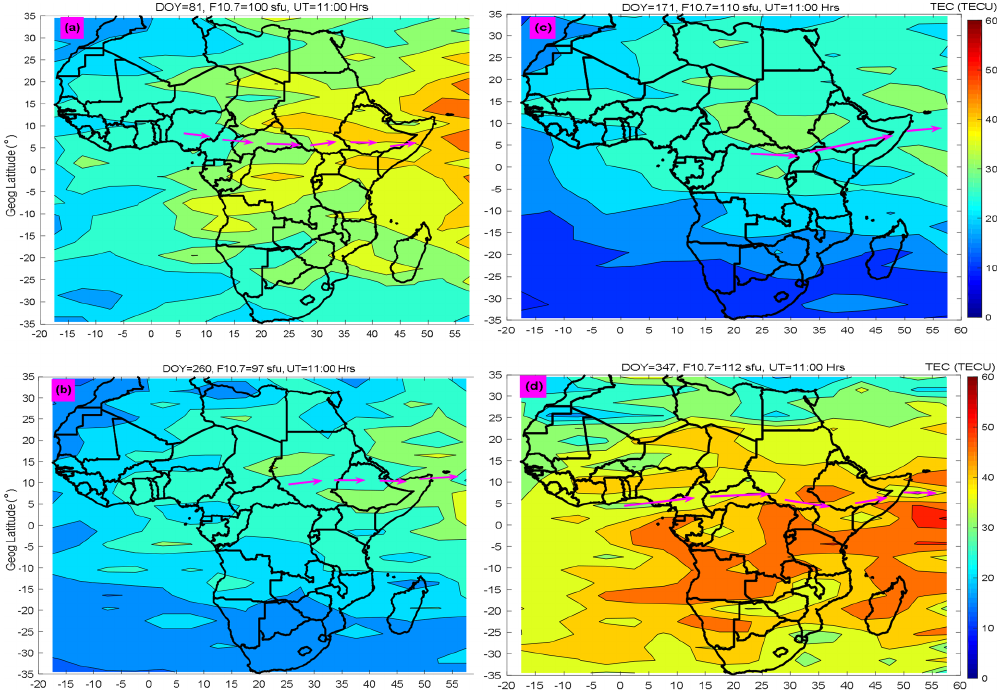
Figure 8. Similar to Fig. 7 but generated by the spline modeling technique. Magenta arrows indicate approximate locations of the EIA trough.